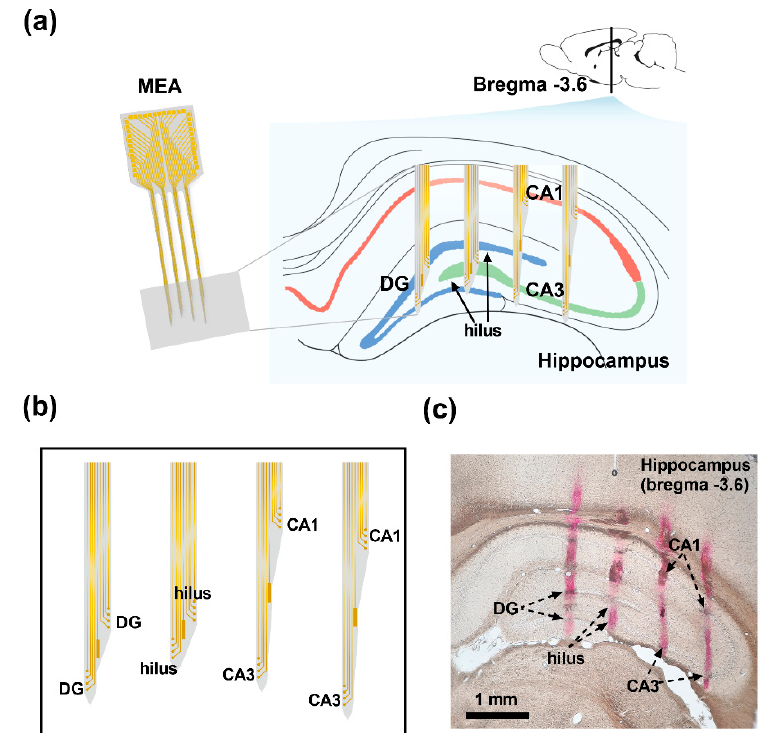
Figure 1. Illustration for the design of the MEA and the implantable position during the in vivo electrophysiological experiment. ( a ) The shape of the MEA. ( b ) Detecting sites were distributed in correspondence to the cell layers of the hippocampus. ( c ) Postmortem histochemistry. The red traces indicate the shanks of the implanted MEA.